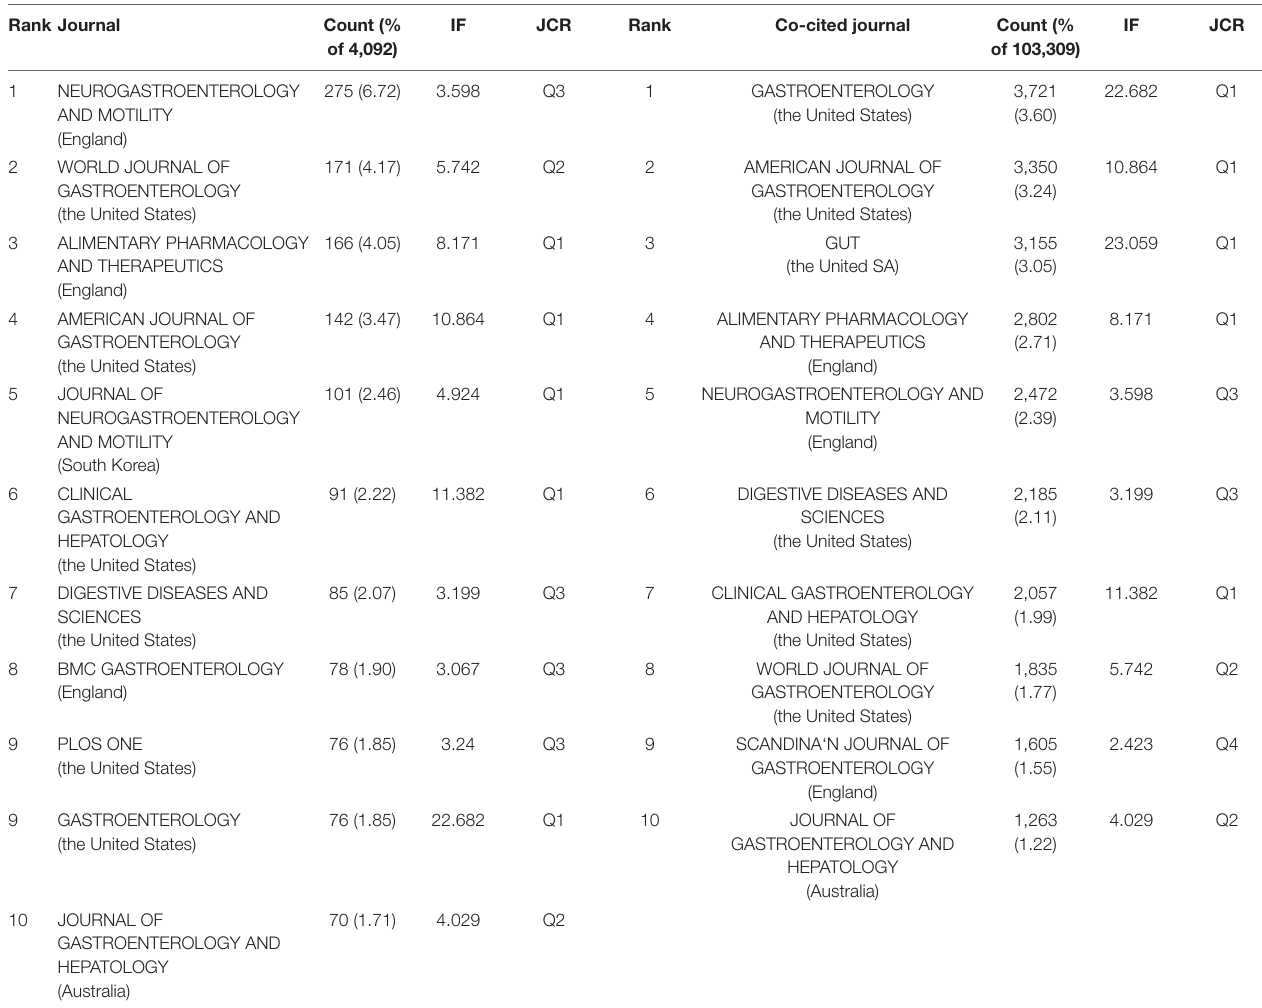
TABLE 3 | Top 10 journal and top 10 co-cited journals in IBS